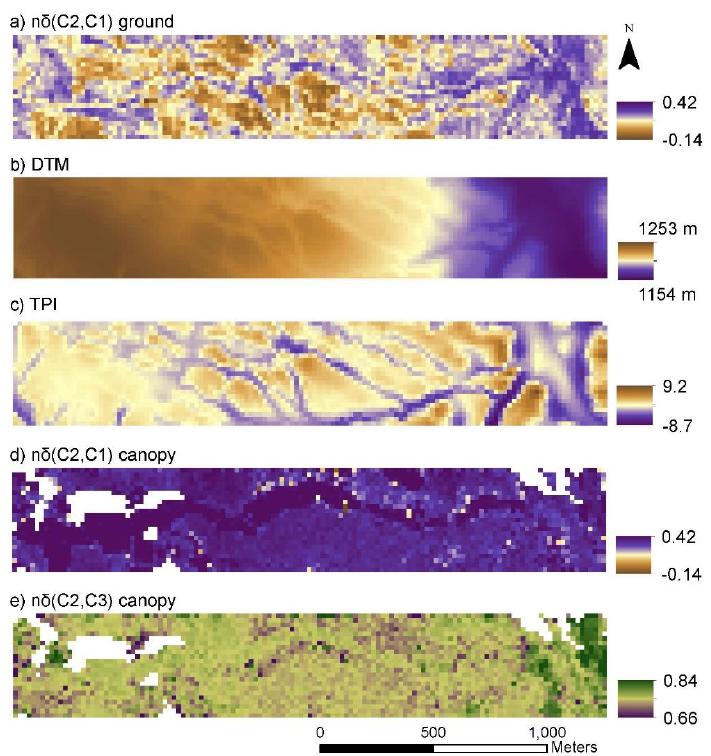
Figure 9. AOI maps of ( a ) ground nδ(C2,C1), ( b ) DTM (Digital Terrain Model), ( c ) TPI (Topographic Position Index), ( d ) canopy nδ(C2,C1), and ( e ) canopy nδ(C2,C3). Note, the AOI covers the same area as presented in Figure 2. Blank (white) pixels represent open areas of insufficient data for canopy SVI generation. Note inverted color ramp in (a) and (d) vs. (b) and (c).